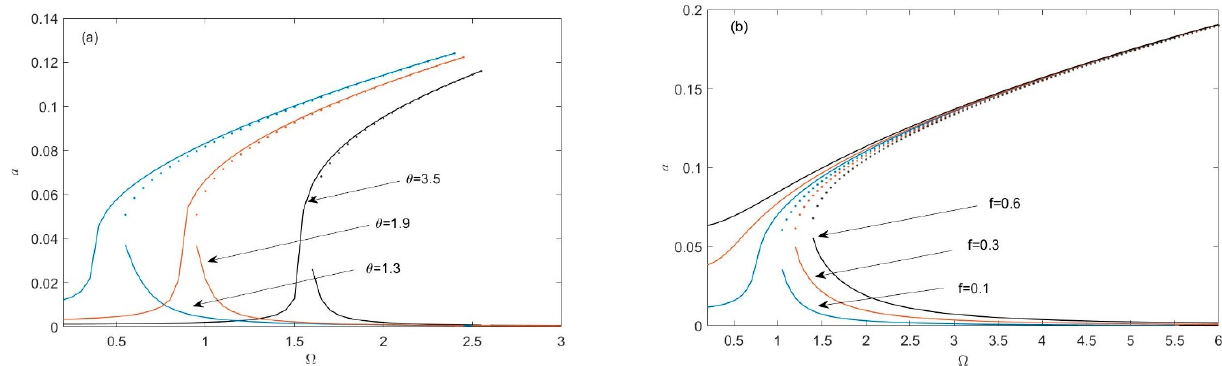
Figure 4. Frequency–amplitude responses of the SMA oscillator system (11) for different parameters: h = 0, ζ = 0.1, β = − 1.3 × 10 3 , γ = 4.7 × 10 5 . ( a ) Temperature θ , f = 0.03; ( b ) amplitude f of the external excitation, θ = 1.9.